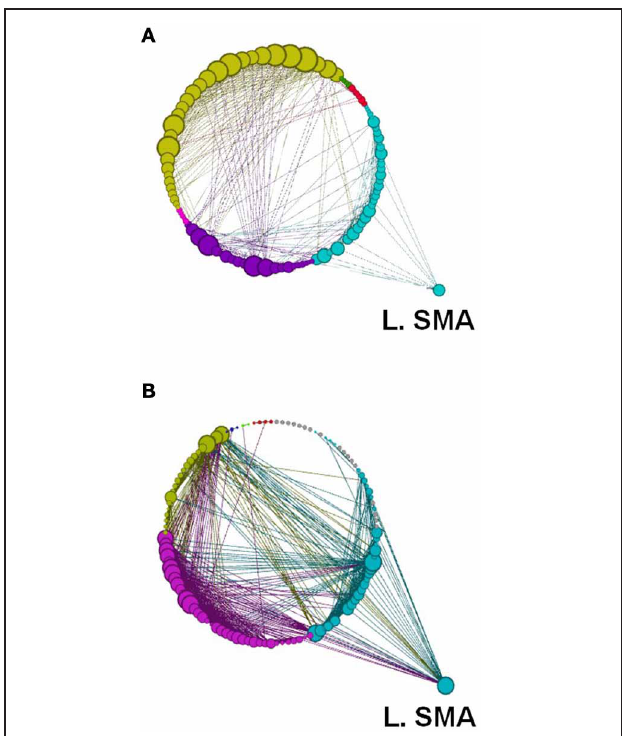
FIGURE 12 | A depiction of network modularity for both (A) REST 1 and (B) REST 2 produced by the Louvain method for community detection and visualized by the force directed Circular Graph algorithm at a threshold of r = 0 . 6 following the explicit SRTT (task 1). This figure also highlights the increased connection of Left SMA in Rest 2 and the node size which is proportional to the degree of the node. Color code for modules are Cyan, Sensory-Motor and Prefrontal; Dark Blue, Fronto-Parietal; Red, Cerebellar. Yellow, Visual and Cerebellar; Green, subcortical.